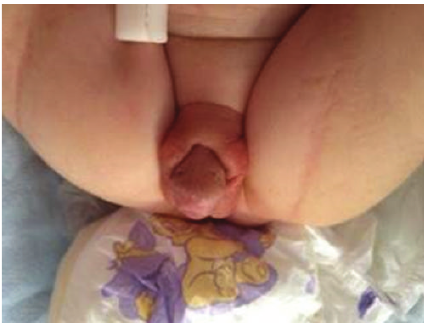
Figure 3: Regression of the phallus at the 7th month of the hormone replacement treatment (constructive operation has not yet been